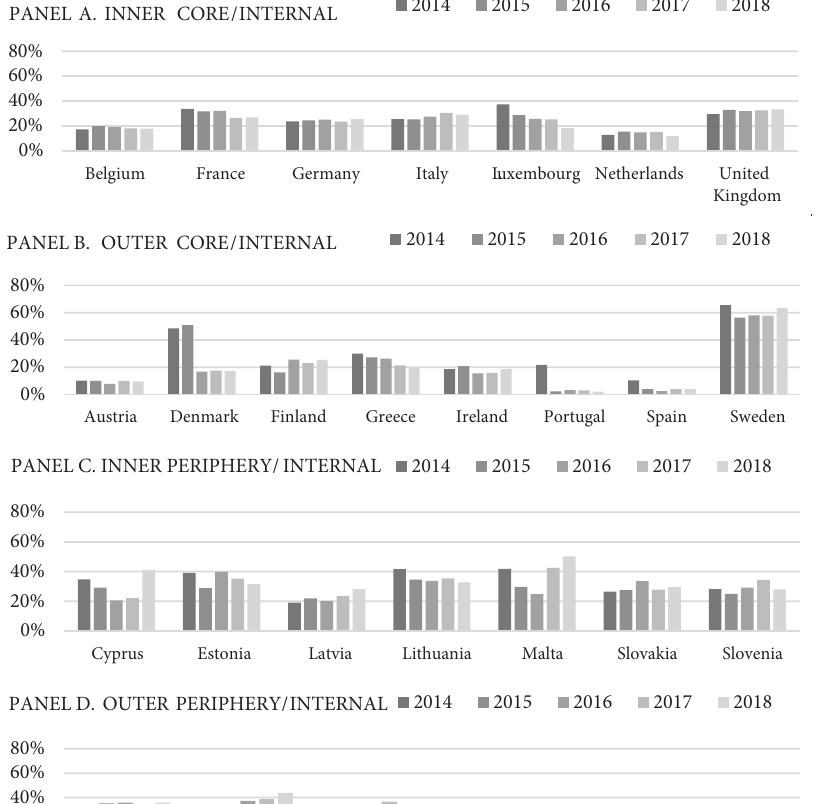
PANEL B. OUTER CORE / INTERNAL